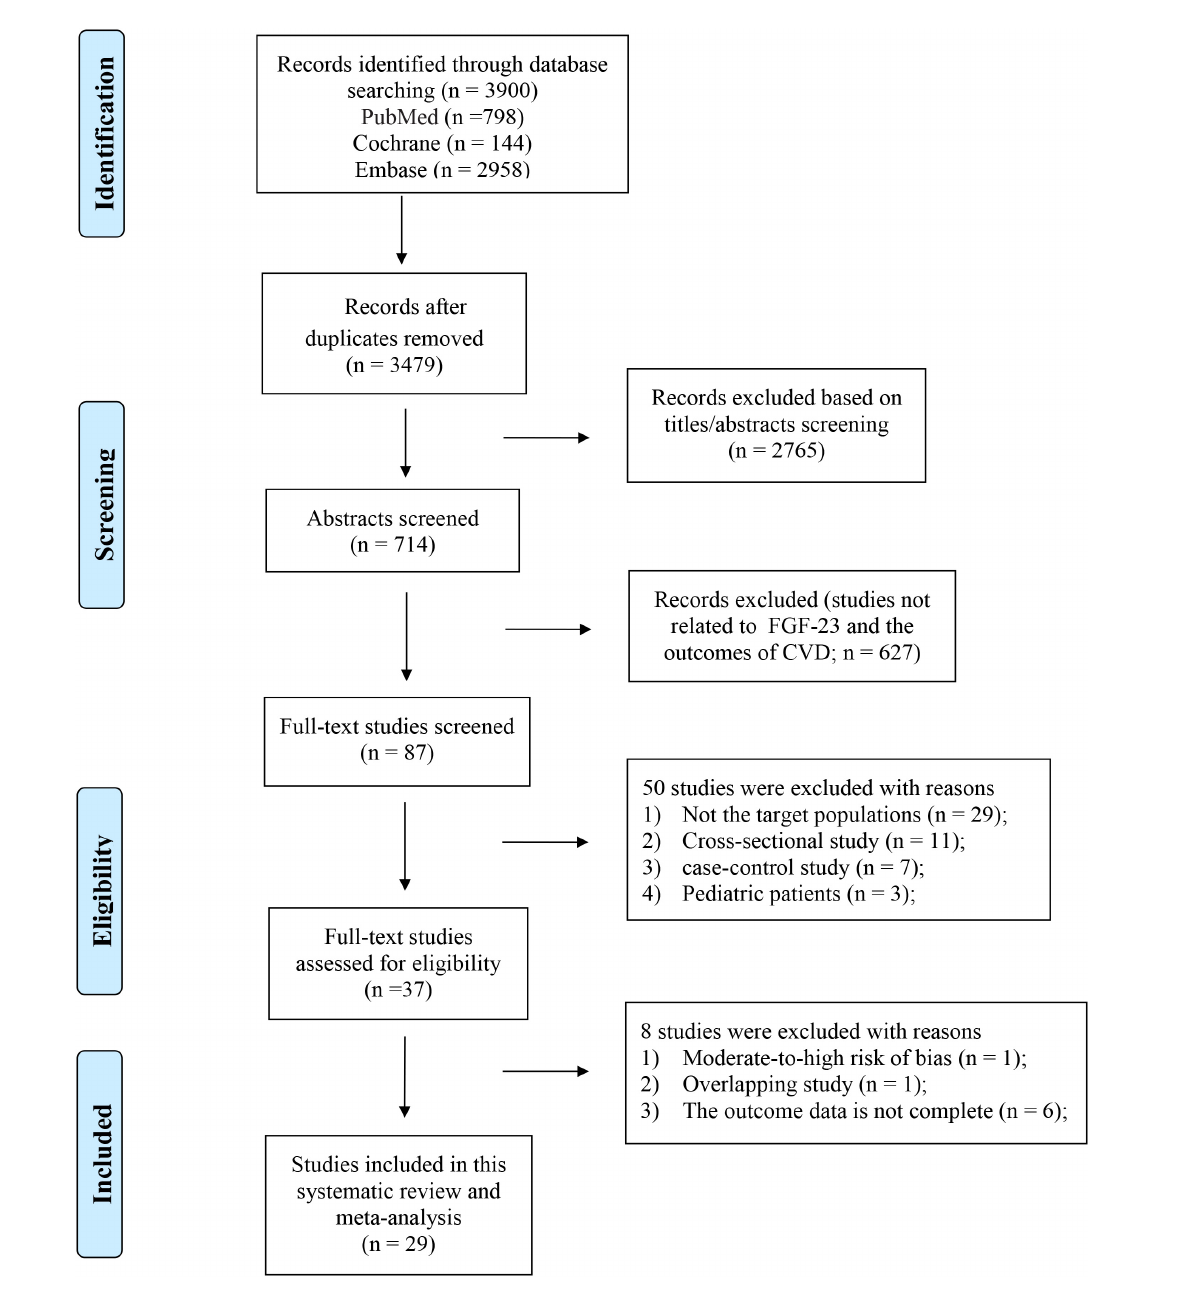
FIGURE1 Flowchart of the study selection investigating the association between levels of FGF23 and risk of CVDs in the general population.